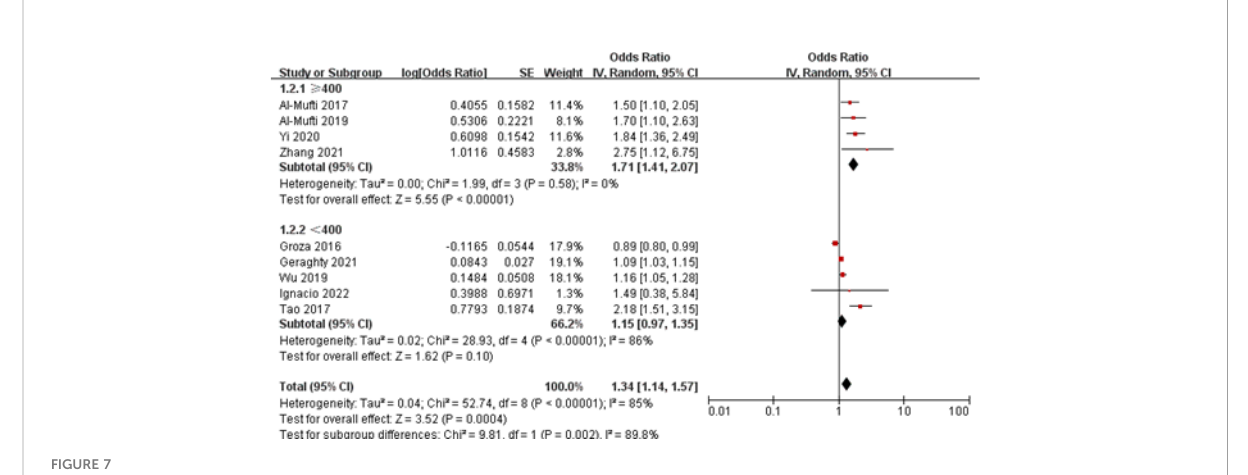
FIGURE 7 Subgroup analysis of NLR and DCI occurrence (sample size